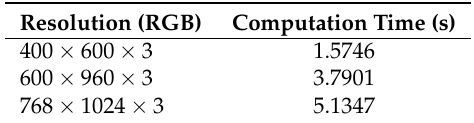
Table 2. Computation time of our algorithm for three